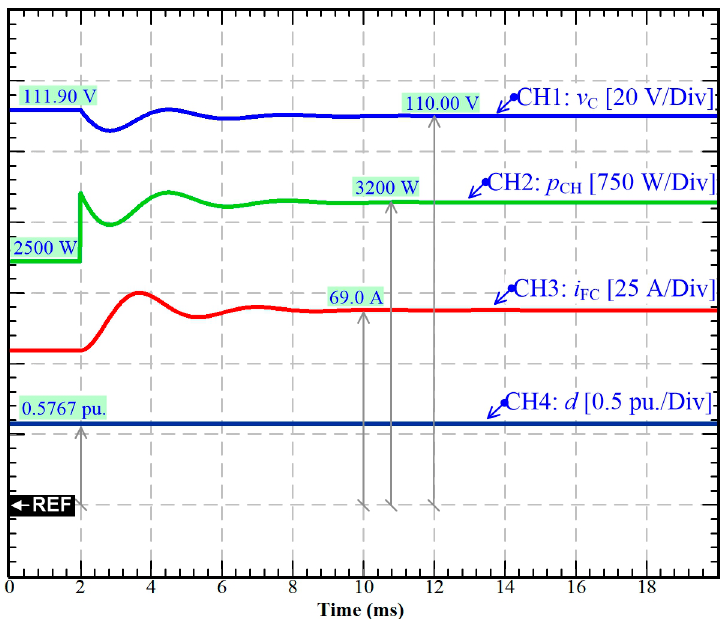
Figure 4. Simulation results: constant resistive loads (CRL) step from 5.00 Ω to 3.78 Ω of the 2-phase FC boost converter with the open-loop control at a constant duty cycle d = 0.5767 (the FC boost converter parameters are expressed in Table A1).